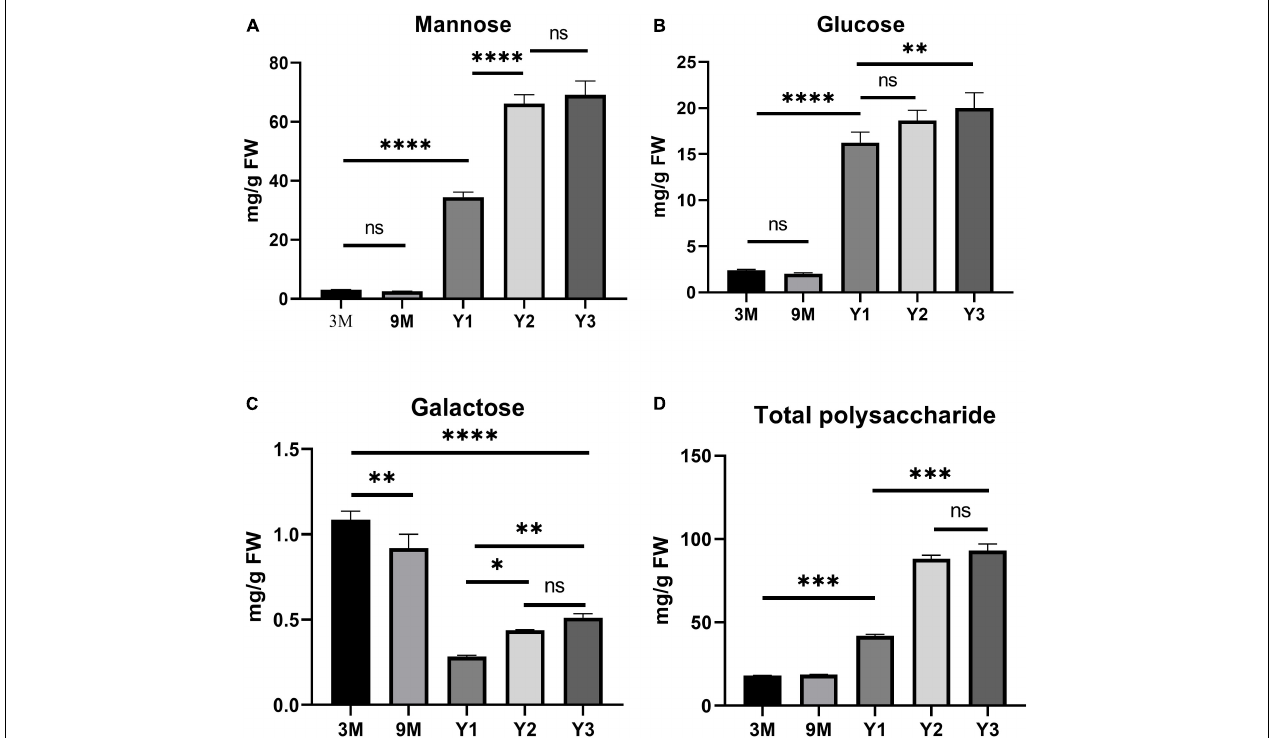
FIGURE 6 | Histogram of the contents of water-soluble polysaccharides and monosaccharide components (mg/g) in the stems of D. officinale in different growth stages, including 3M, 9M, Y1, Y2, and Y3. (A) Mannose content; (B) glucose content; (C) galactose content; (D) total polysaccharide content. * p value < 0.05, ** p value < 0.01, *** p value < 0.001, **** p value < 0.0001.